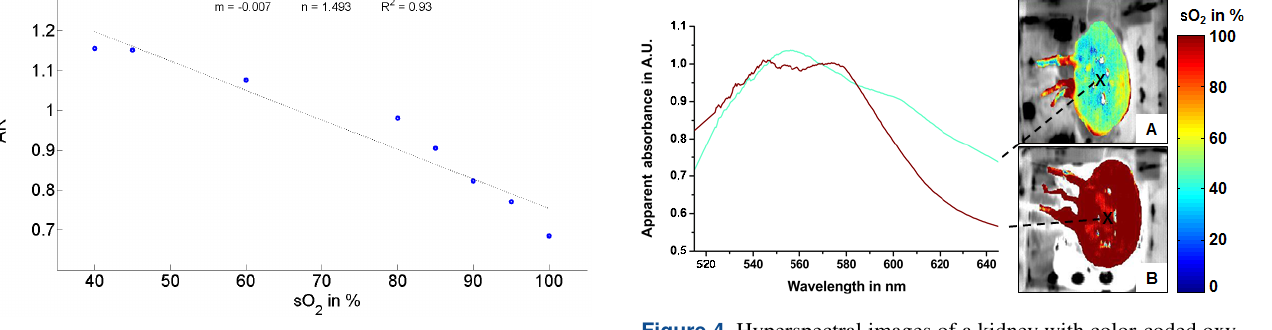
Figure 3. Correlation of calculated AR values from HSI measure- ments of calibration blood probes with the oxygen saturation of the blood probes (blue circles). The calculated oxygen saturation from HSI measurements during NMP is based on the linear regression of AR and oxygen saturation of the blood probes (dotted line).